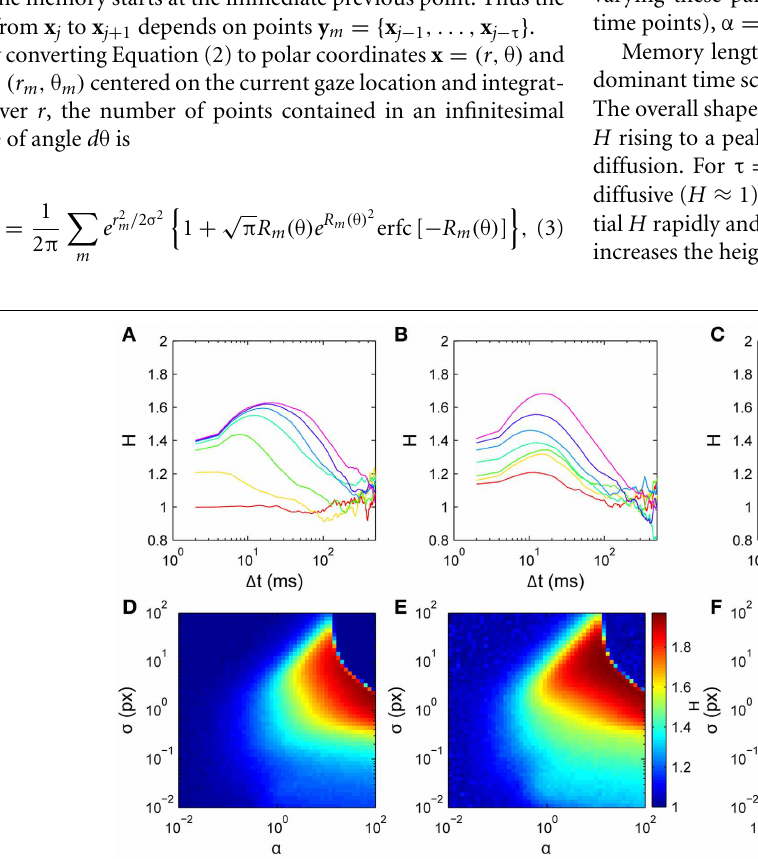
memory precision σ ; curves from bottom to top are for log 10 σ = − 2 , − 1 . 6 , − 1 . 2 , − 0 . 8 , − 0 . 4 , 0 , 0 . 4, respectively. (C) Varying memory penalty strength α ; curves from bottom to top are for log 10 α = − 2 , − 4 / 3 , − 2 / 3 , 0 , 2 / 3 , 4 / 3 , 2, respectively. Bottom row: 2-D parameter space σ vs α with τ =10. (D) H 1 . (E) H peak . (F) (cid:2) t peak